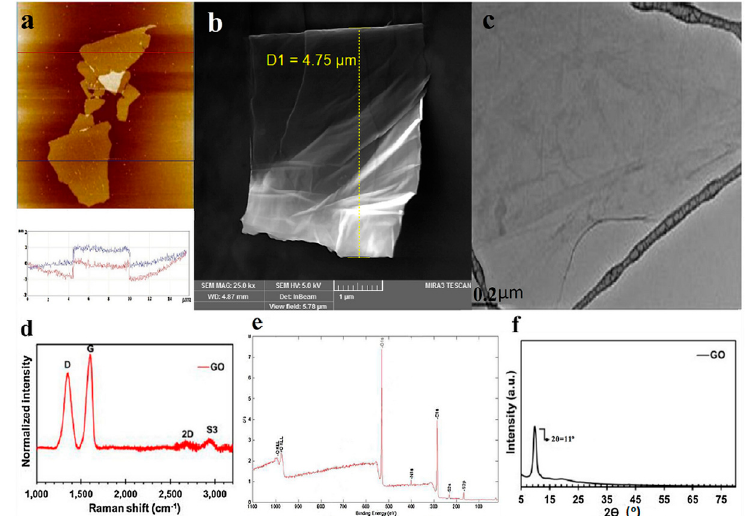
Figure 1. Morphological and structural characterization of graphene oxide ( a ) Atomic Force Microscopy (AFM), ( b ) Field Emission Scanning Electron Microscopy (FESEM), ( c ) High-resolution transmission electron microscopy (HR-TEM), ( d ) Raman Spectrometry, ( e ) X-ray photoelectron spectroscopy (XPS), and ( f ) X-ray diffraction (XRD). (Adapted with permission from ref. [48] 2020 Elsevier) .